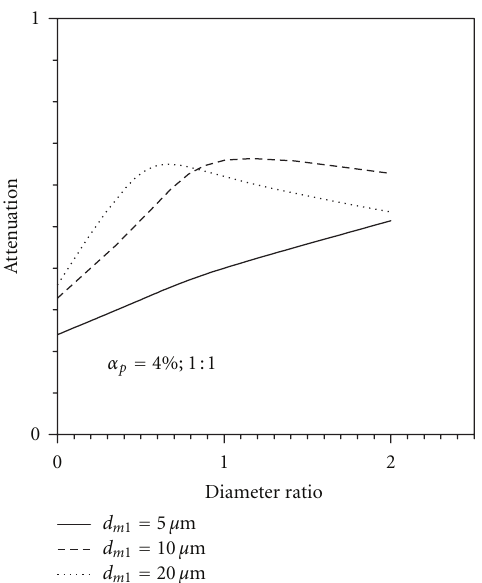
Figure 16: Nondimensional attenuation as function of particle diameter ( d m 2 : d m 1 ), for a 1:1 loading distribution for two sets of particles at total loading of 4%, reference motor, acceleration nullified.